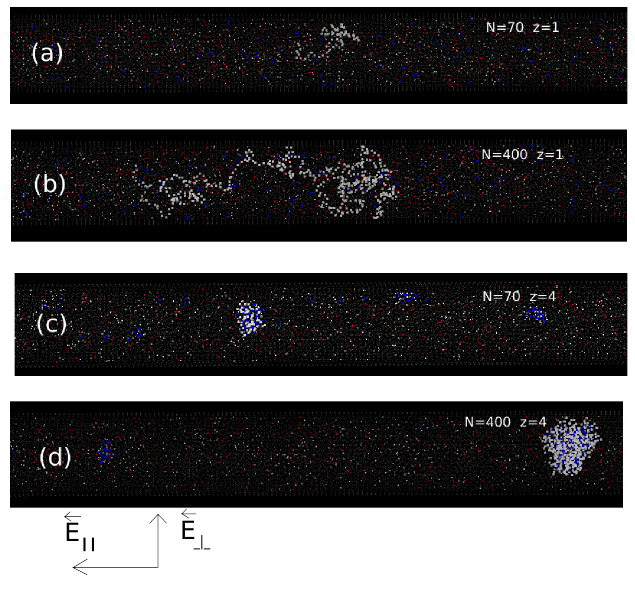
Figure 1. Sideview snapshots of equilibrium configurations for chains of length ( a ) N = 70 ; ( b ) N = 400 with monovalent counterions; and ( c ) N = 70 and ( d ) N = 400 with tetravalent counterions. The polymer monomers and coions are represented in white, the gray is for solvent and wall particles, the red color represents monovalent counterions, and the blue color is used for monovalent or tetravalent counterions. The radius of the straight cylinder is R = 7 . 74 . A schematic of the applied electric field components is shown under the graphs. The longitudinal field ~E is orientated along the cylinder axis, while the transversal field ~E k is perpendicular to the cylinder